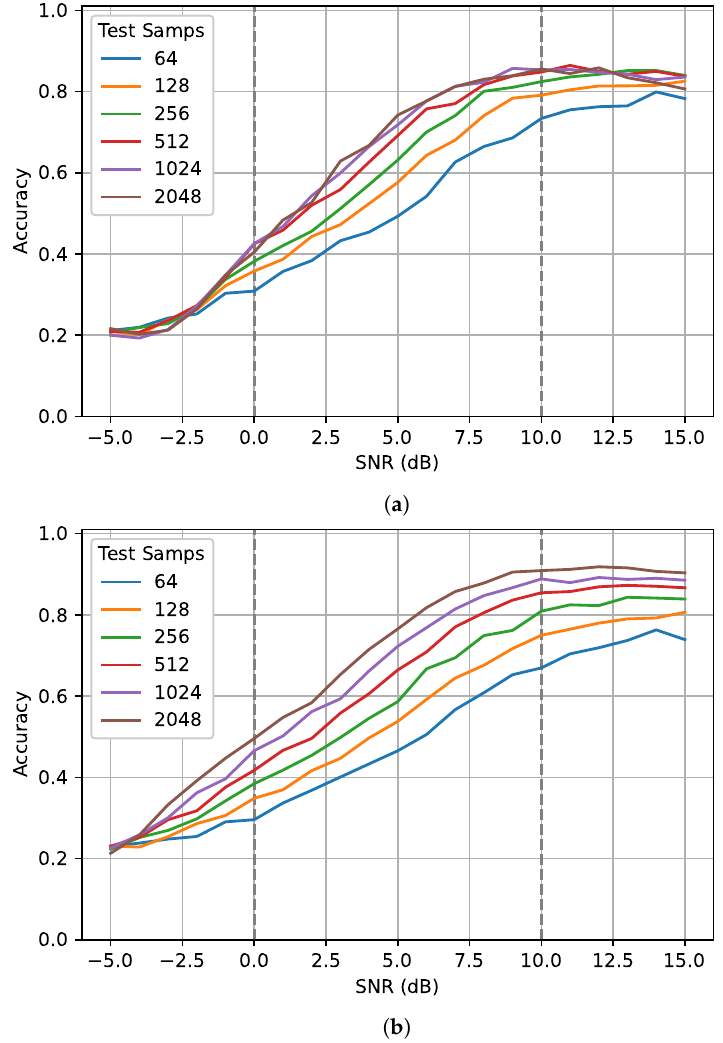
Figure 5. The impact of different training and testing sequence lengths on performance for different SNRs. Sequence lengths of 64, 128, 256, 512, 1024, and 2048 were tested on the best network trained on ( a ) 128 samples and ( b ) 1024 samples. The gray dotted lines show the SNR training